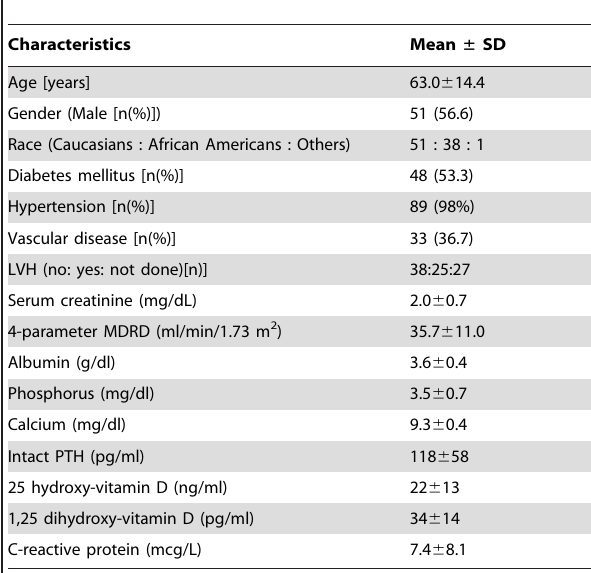
Table 1. Characteristics of stage 3–4 CKD patients